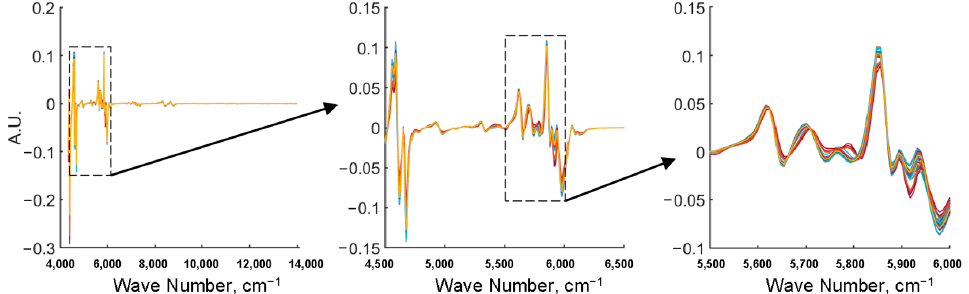
Figure 3. NIR spectra of all the samples in the library after